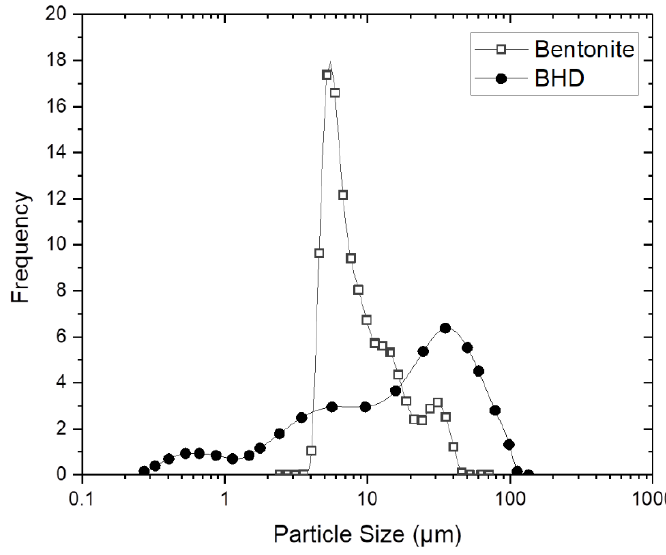
Figure 4. Particle size distribution of steel dust (BHD) compared to bentonite.